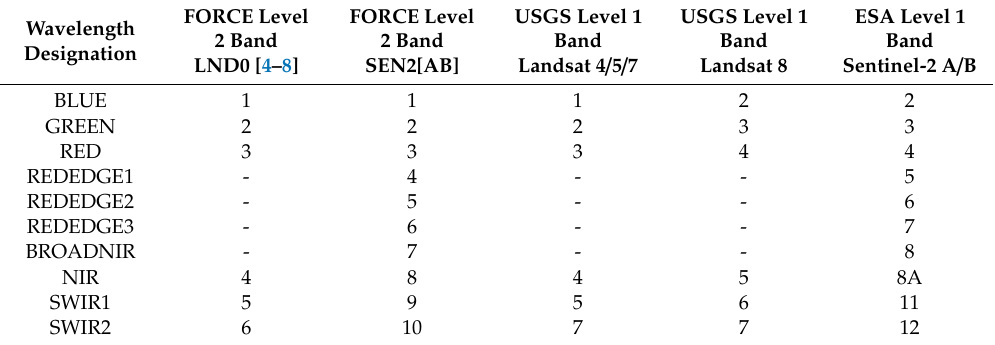
Table 1. Level 2 output bands and mapping to original Level 1 bands.